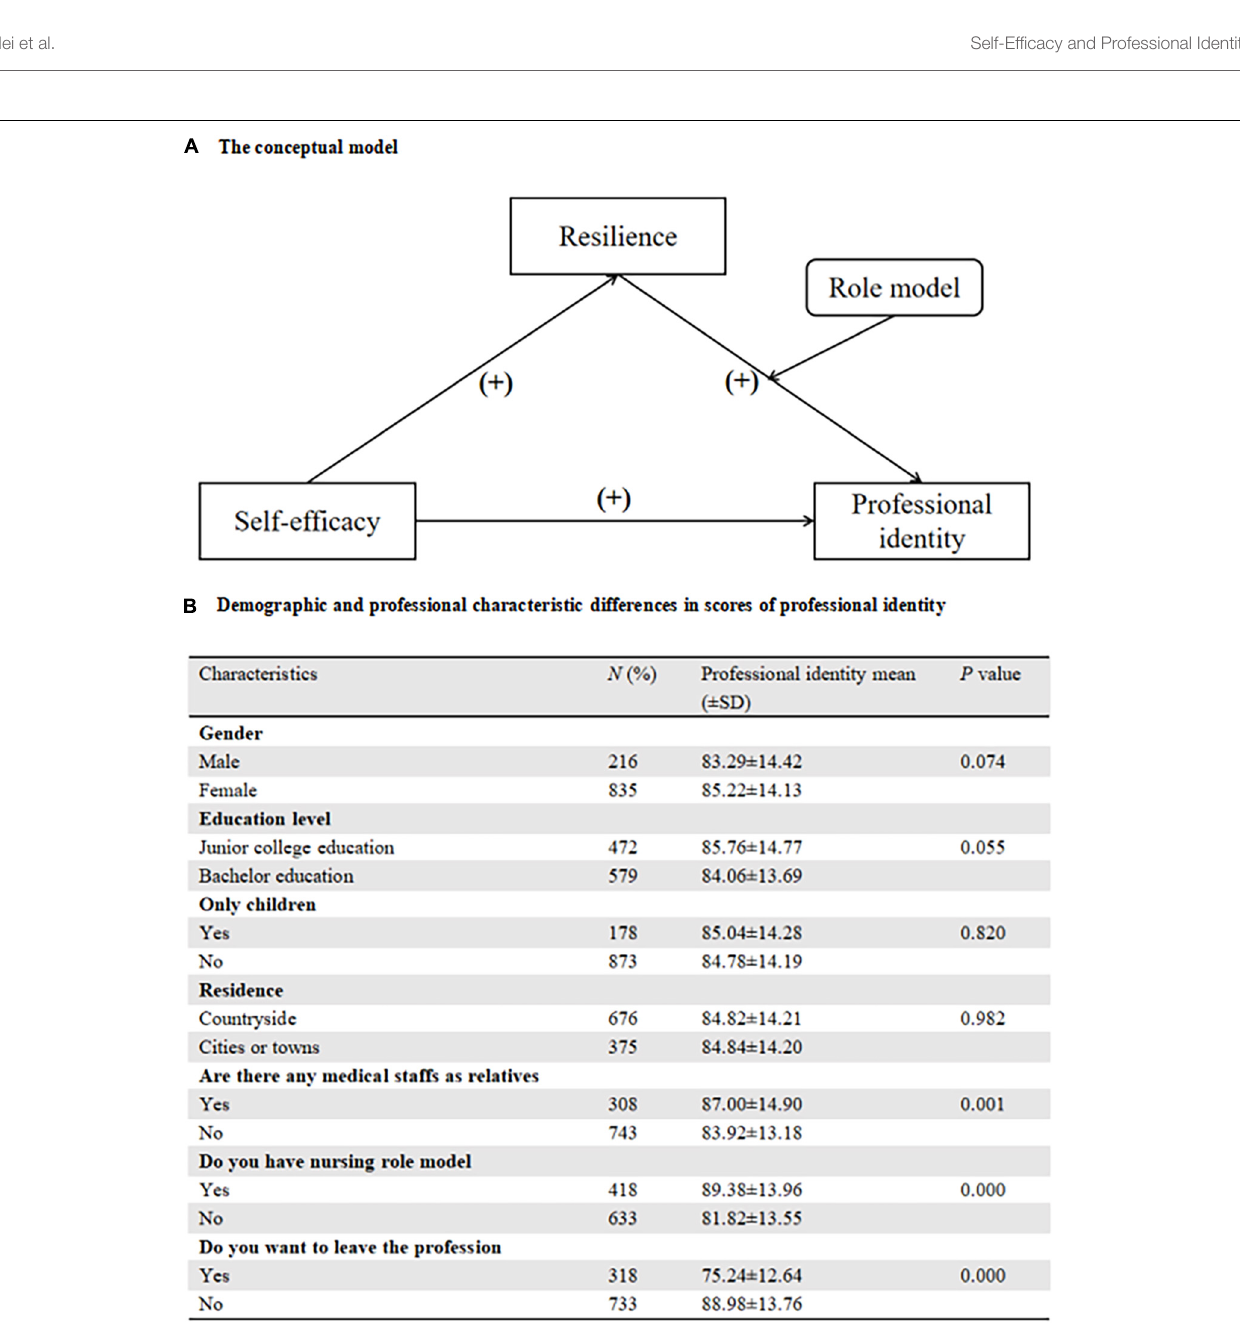
FIGURE 1 | (A) The Conceptual model. (B) Demographic and professional characteristic differences in scores of professional